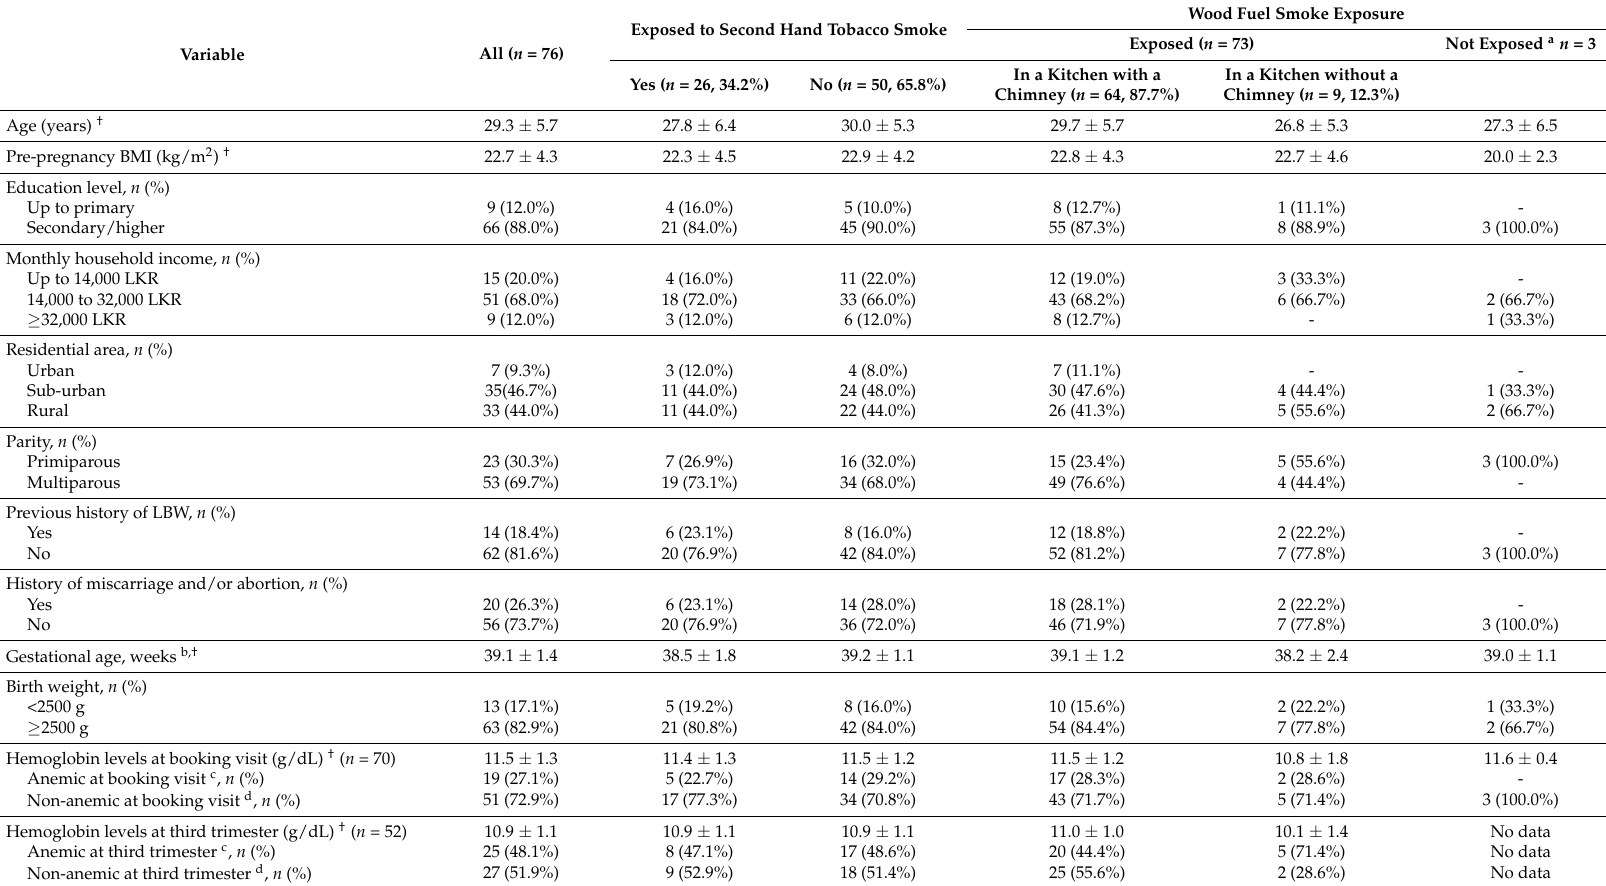
Table 1. Characteristics of the